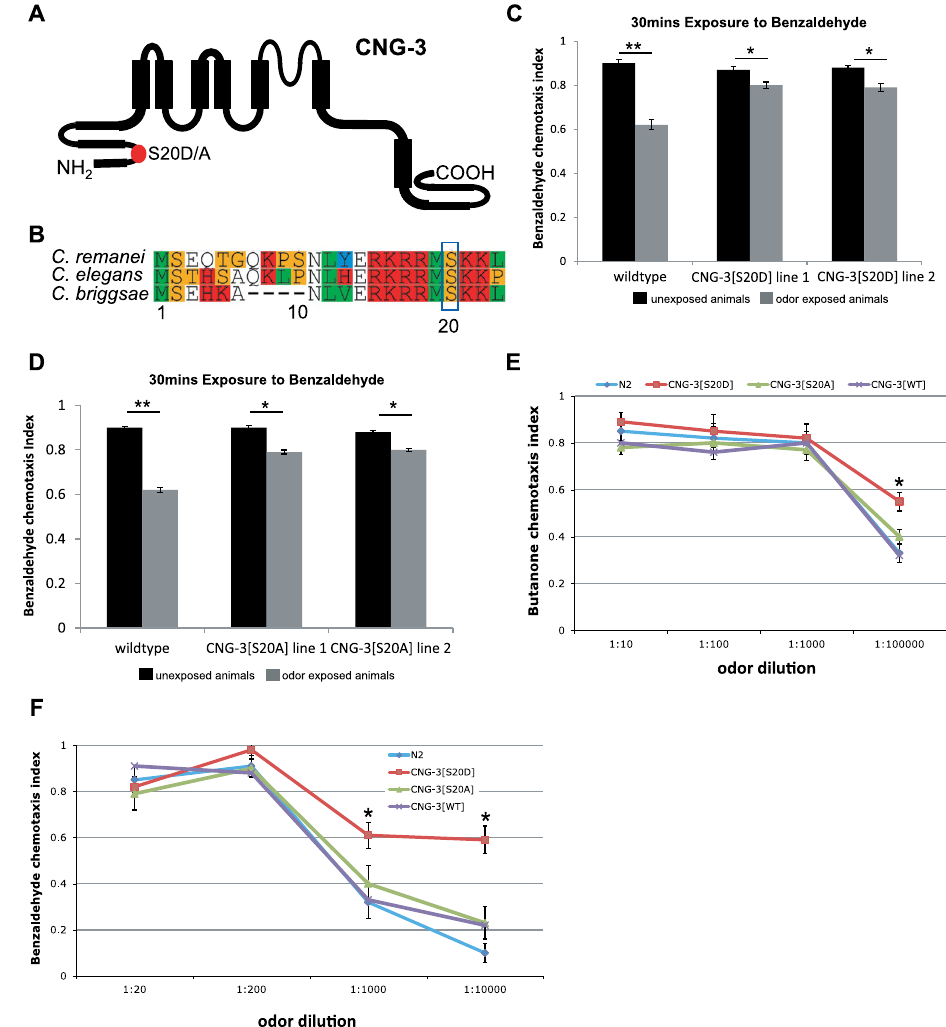
Figure 3. A candidate PKG site in CNG-3 is important for tuning odor sensitivity. ( A ) Cartoon structure of CNG-3 highlighting the position of the candidate PKG site at Serine 20 (S20) which was mutated to an Aspartic acid (S20D) to generate a phosphomimetic allele of CNG-3 and was mutated to an Alanine (S20A) to generate a phosphorylation defective allele of CNG-3. ( B ) Alignment of CNG-3 orthologues from C. elegans , C remanei , and C. briggsae reveal that this candidate PKG site is conserved. ( C ) Wildtype animals exhibited a significant change in chemotaxis index after 30 mins odor exposure as compared with unexposed animals (ANOVA with Tukey’s HSD, ** p < 0.01). Transgenic animals expressing CNG-3(S20D) also exhibited a significant change in chemotaxis index after 30 mins odor exposure when compared with unexposed animals (ANOVA with Tukey’s HSD, * p < 0.05). ( D ) The chemotaxis response of two independent transgenic lines that express the phosphorylation defective version of CNG-3 (i.e. S20A) was examined and compared to wildtype responses. Wildtype animals exhibited a significant change in chemotaxis index after 30 mins odor exposure as compared with unexposed animals (ANOVA with Tukey’s HSD, * p < 0.01), and similarly the transgenic lines (line 1, 2 nd set of bars and line 2, 3 rd set of bars) expressing CNG-3(S20A) exhibited a significant change in chemotaxis index after 30 mins odor exposure when compared with unexposed animals (ANOVA with Tukey’s HSD, * p < 0.05). ( E,F ) Wildtype animals and animals expressing the normal wildtype version of CNG-3[WT], a phosphomimetic version of CNG-3(S20D) or the phosphorylation defective version of CNG-3(S20A) were tested for their ability to sense butanone ( E ) and benzaldehyde ( F ) at various concentrations. In each case the animals expressing CNG-3(S20D) exhibited a greater sensitivity to each odor at more dilute concentrations as compared with wildtype animals or animals expressing the phosphorylation defective version of CNG-3(S20A). (ANOVA with Tukey’s HSD, * p < 0.05). For all graphs, error bars represent